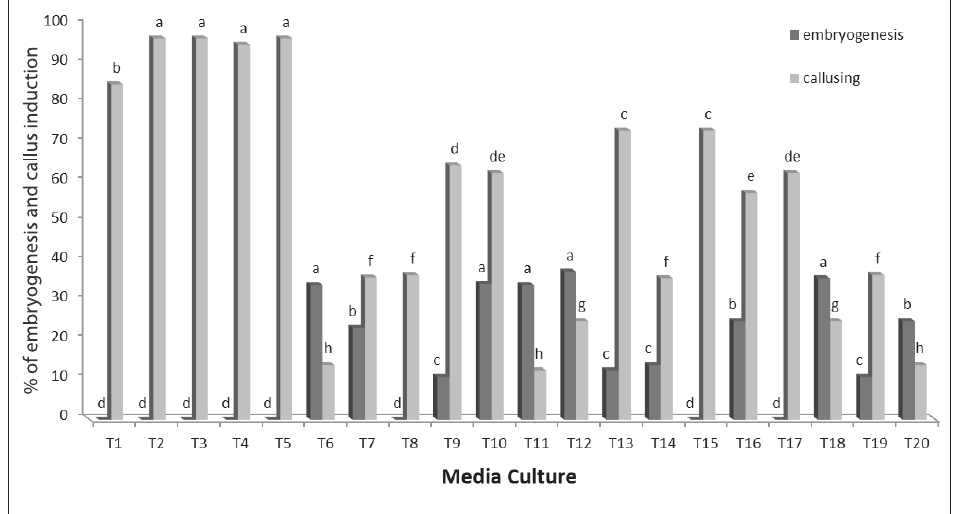
Fig. 2: Effects of different hormonal combinations on embryogenesis and callus induction in experiment 2. For every trait, letters compared separately. Means followed by a common letter are not significantly different at 5% level according to LSD test T1: KIN+2,4-D (1.25+0.5 mg·l -1 ); T2: KIN+IAA (1.5+1 mg·l -1 ); T3: BAP+2,4-D (2+0.5 mg·l -1 ); T4: 2,4-D (3 mg·l -1 ); T5: KIN+BAP+IAA+IBA (0.5+0.5+ 0.5+0.5 mg·l -1 ); T6: BAP+2,4-D+NAA (1.75+2+1 mg·l -1 ); T7: BAP+NAA (3+1.5 mg·l -1 ); T8: KIN+BAP+IAA (2.5+1.5+1 mg·l -1 ); T9: KIN+BAP+2,4-D (2.5+